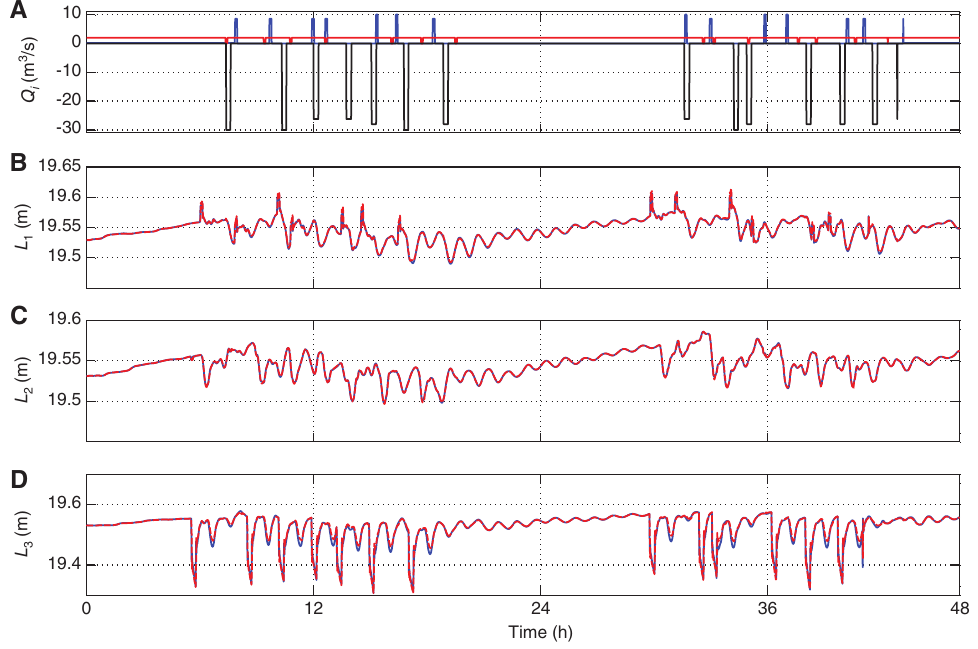
Figure 11. Scenario 2 of Two Navigation Days with the Cuinchy Lock and Fontinettes Lock Operations. (A) Discharges in Cuinchy (Blue Line), in Aire-sur-la-Lys (Red Line), and in Fontinettes (Black Line). Estimated (Red Dashed Line) and Measured (Blue Con- tinuous Line) Levels at (B) Cuinchy L , (C) Aire-sur-la-Lys L , and (D) Fontinettes L 1 2 3